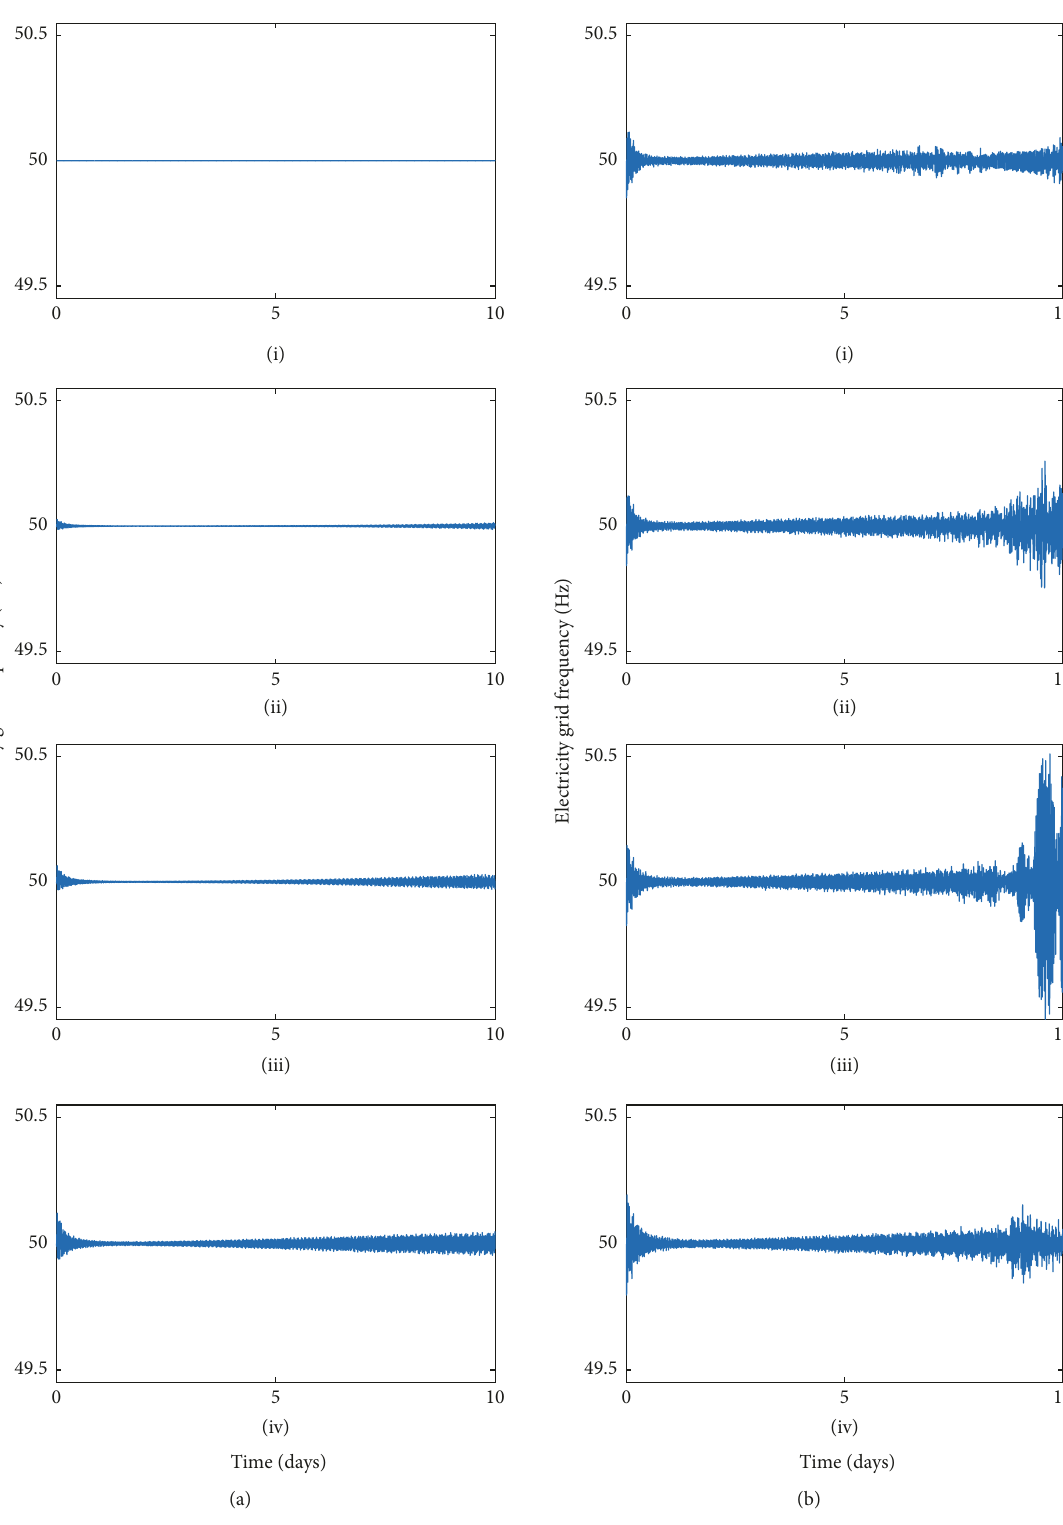
Figure 10: Electricity grid frequency over 10 days (values plotted once per 5 minutes), with fridge distributions as described in Table 3 and Figures 8 and 9. The perturbed systems (all but a(i)) see an initial reduction in oscillation amplitude followed by oscillation